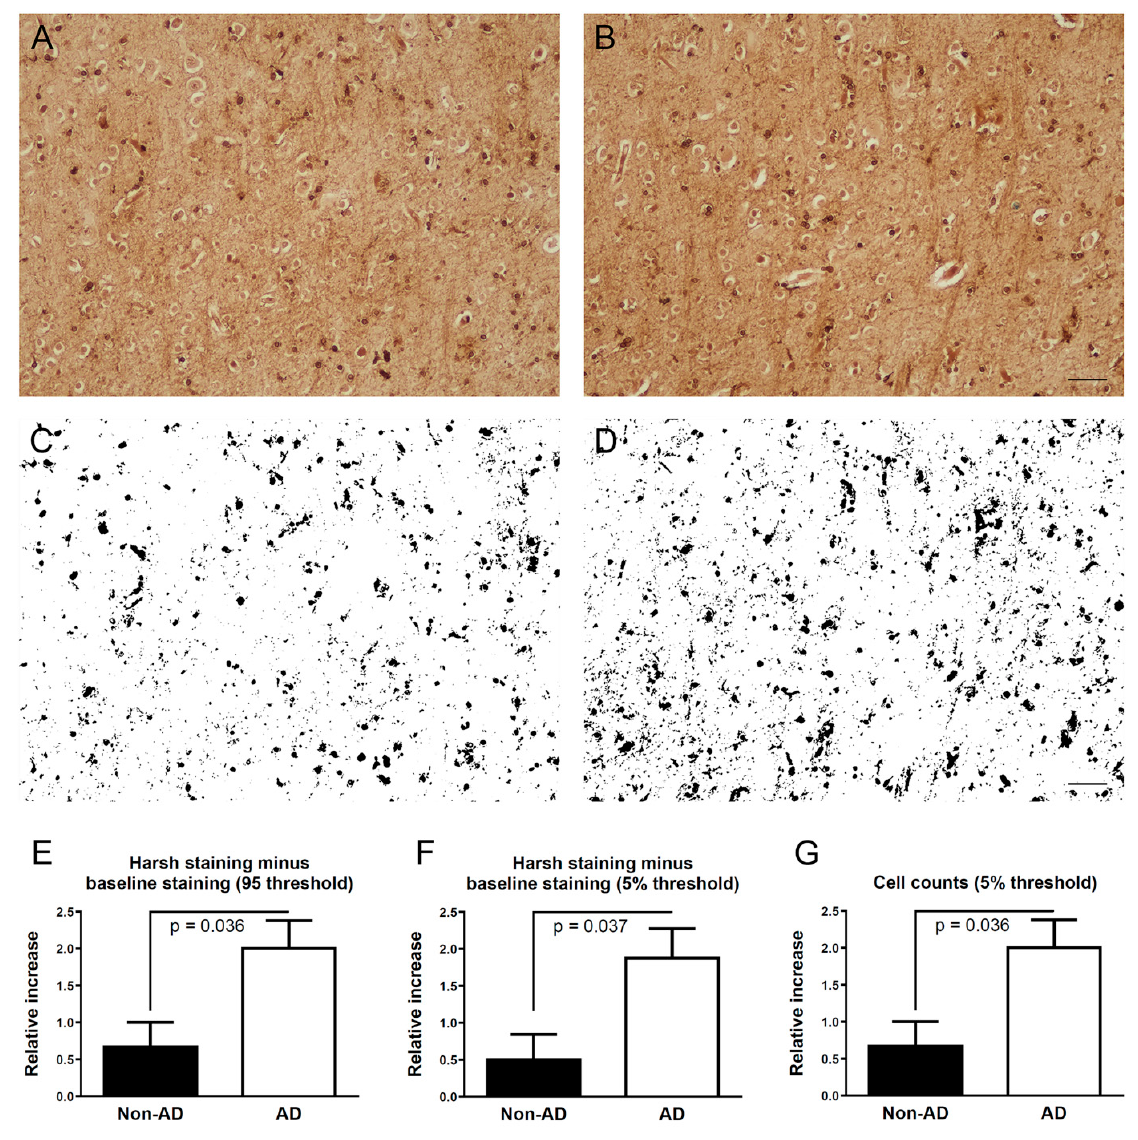
Figure 1. Comparison of staining using baseline and harsh conditions for iron histochemistry. ( A ) A section of frontal cortex from a patient with AD stained with baseline conditions reveals neuropil and cellular staining; ( B ) The matching cortical region of the same patient as in ( A ) but stained using harsh conditions reveals darker overall staining than in panel ( A ); ( C ) Thresholding of baseline staining from the image in ( A ) reveals cellular and neuropil staining that crossed the threshold setting of 95 (range 0–255); ( D ) Thresholding of staining with harsh conditions from the image in ( B ) reveals cellular and neuropil staining that crossed the threshold setting of 95. Note the greater abundance of staining in ( D ) than in ( C ); ( E , F ) The relative abundance of stained area (harsh staining minus baseline staining) using a threshold of 95 ( E ) or 5% ( F ) from 3 cortical regions per patient; ( G ) The relative abundance of stained cells (harsh staining minus baseline staining) using a threshold of 5% from 3 cortical regions per patient. Two-tailed Mann–Whitney U test, mean with standard error of the mean. Non-AD subjects (n = 6), patients with AD (n = 8). Bar in B and D = 50 µm.